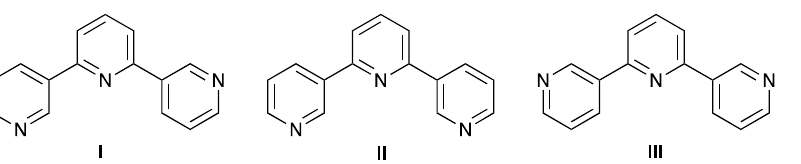
Scheme 5. The three limiting planar conformations, I–III , of 3,2 (cid:48) :6 (cid:48) ,3 (cid:48)(cid:48) -terpyridine. Conformation I is observed in the single crystal structure of 3 .